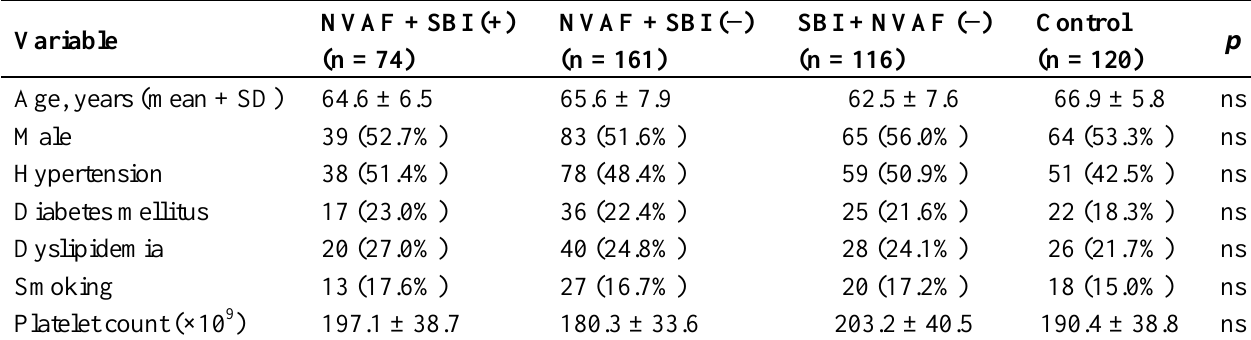
Table 1. Baseline characteristics of each